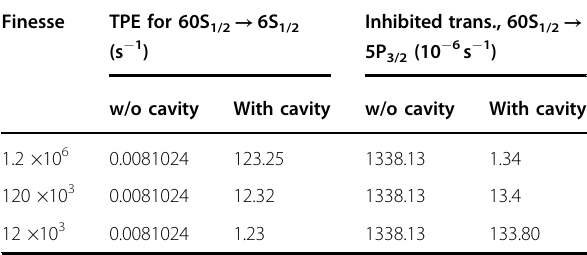
Table 2 Comparison between the TPE rates and the one-photon rates for rubidium atom inside the